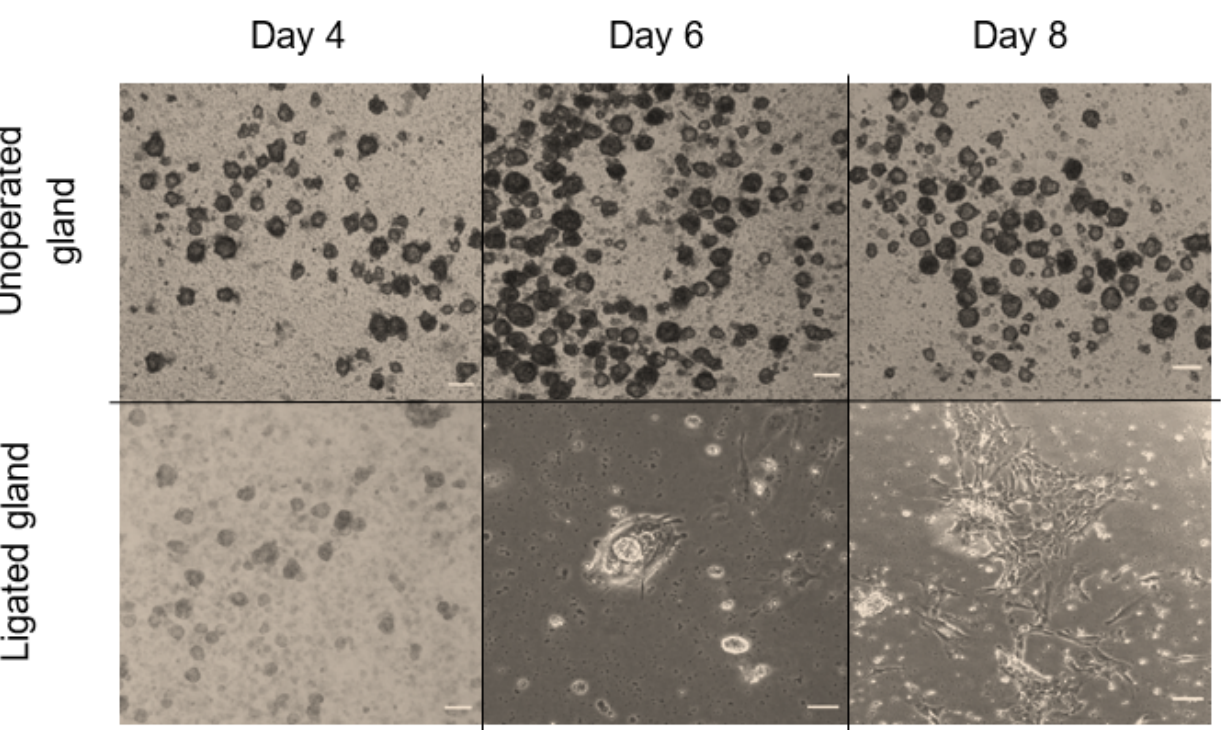
Figure 6. Morphological comparison between grown salispheres from unoperated and ligated glands at different time points of culture (day 4, 6, and 8) (scale bar = 10 µ m). On day four of culture, salispheres appeared similar to healthy growing salispheres from unoperated glands. Grown salispheres from ligated glands behaved differently around day 6 of culture. Unlike healthy salispheres (cultured from unoperated glands), they first attach to the plastic dish (day 6), and then form fibroblastic-like structures, which increase over time of culture (day 8).